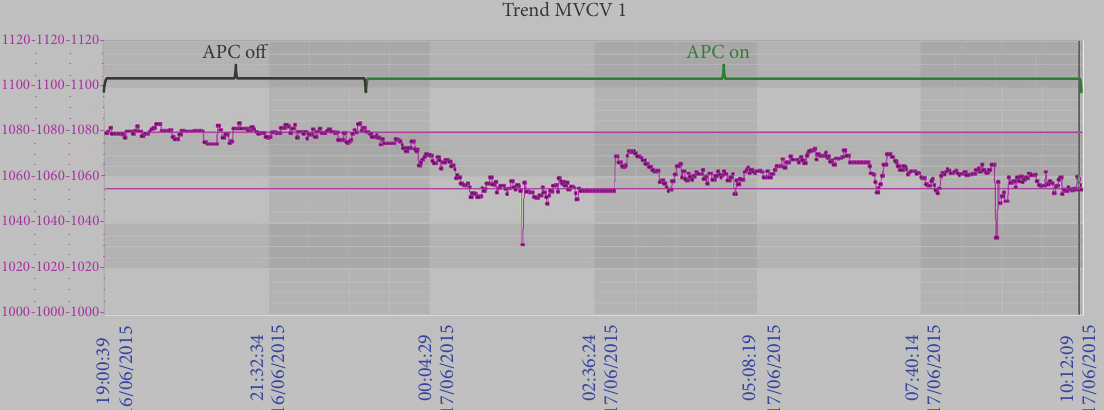
Figure 15: Billets final temperature trends and related constraints.